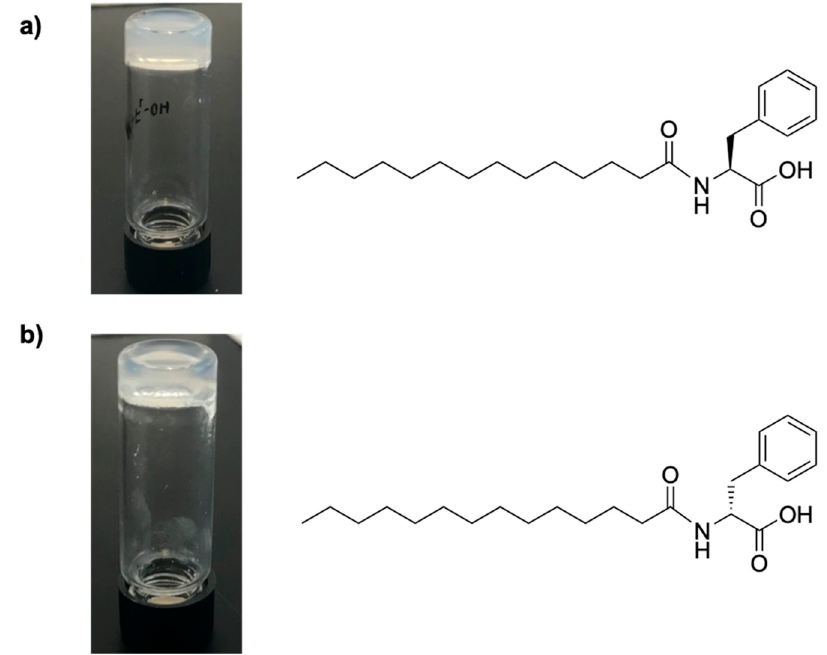
Figure 1. ( a ) Aliphatic-amino acid hydrogel shown through an inverted vial test and the molecular structure of MA- l -Phe-OH; and ( b ) aliphatic-amino acid hydrogel shown through an inverted vial test and the molecular structure of MA- d -Phe-OH. Table 1. MGC, T gel , and Tan δ (all at 1%) values of hydrogels in 50 mM monobasic phosphate bu ff er at pH